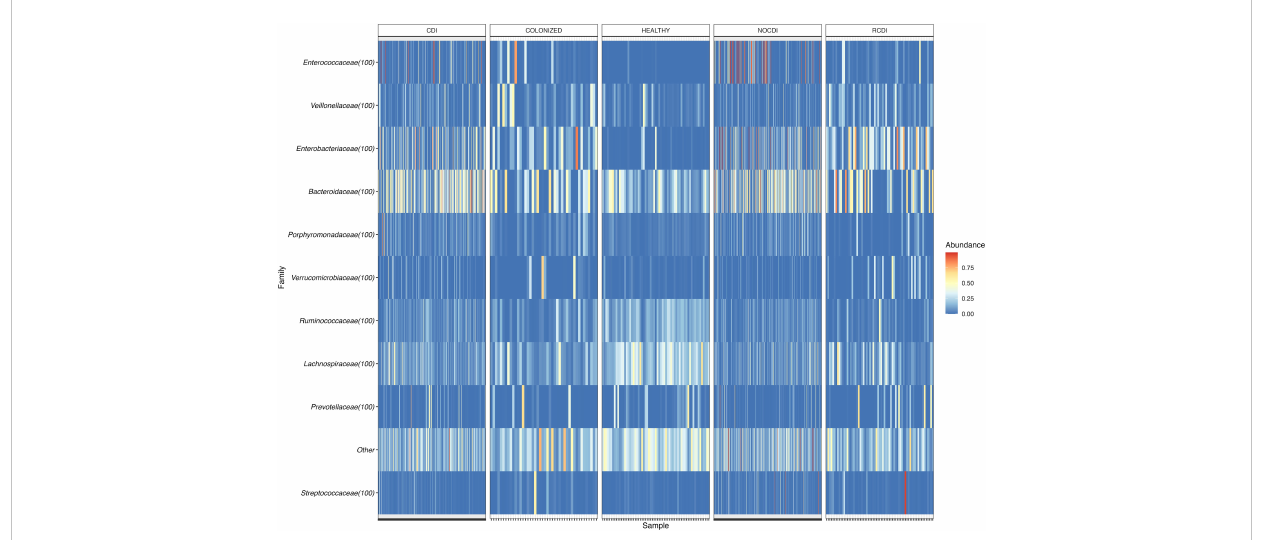
FIGURE 3 Heatmap of family relative abundance in each sample. CDI, Clostridioides dif fi cile infection; NOCDI, Non C. dif fi cile diarrhoea; RCDI, recurrent CDI; Colonized, patients colonized with C. dif fi cile ; Healthy, Healthy subjects.